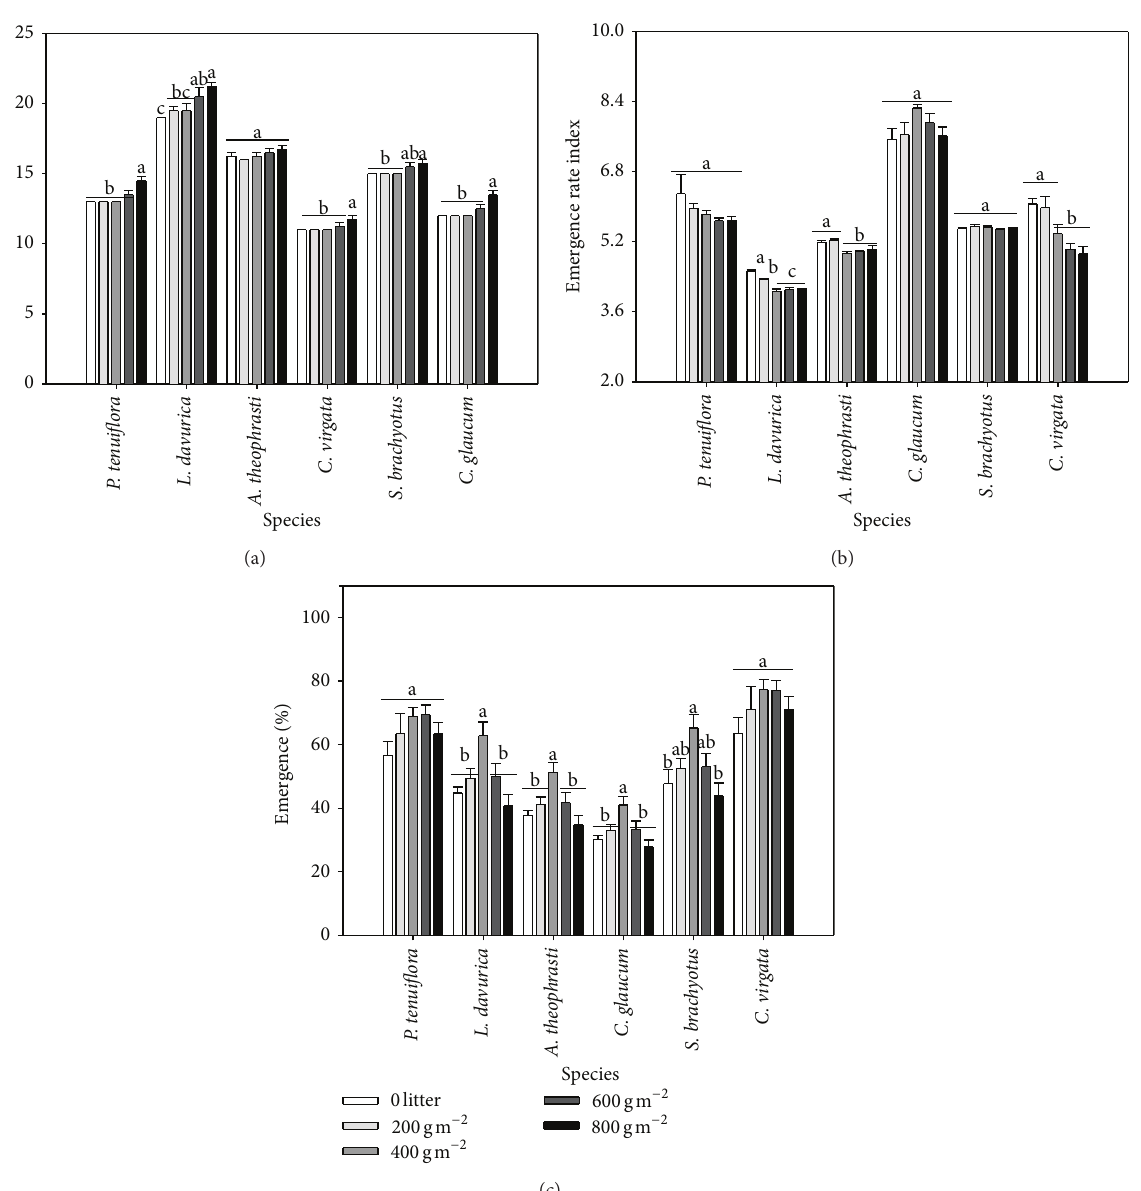
Figure 3: The emergence time (a), emergence rate (b), and emergence percentage (c) of seedling under different species and litter covers. The values were represented as mean + SE; different letters indicate significant difference between treatments at 𝑃 < 0.05